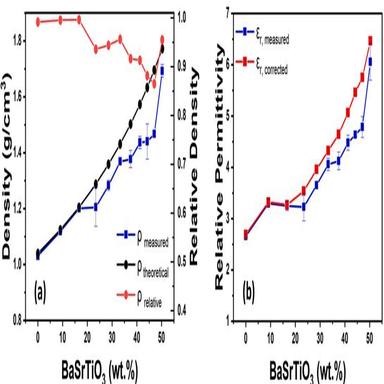
BST/ABS solid loading vs. (a) Density of 3D Printed test samples, (b) measured and corrected for porosity relative permittivity values of the 3D printed test samples at 5 GHz.